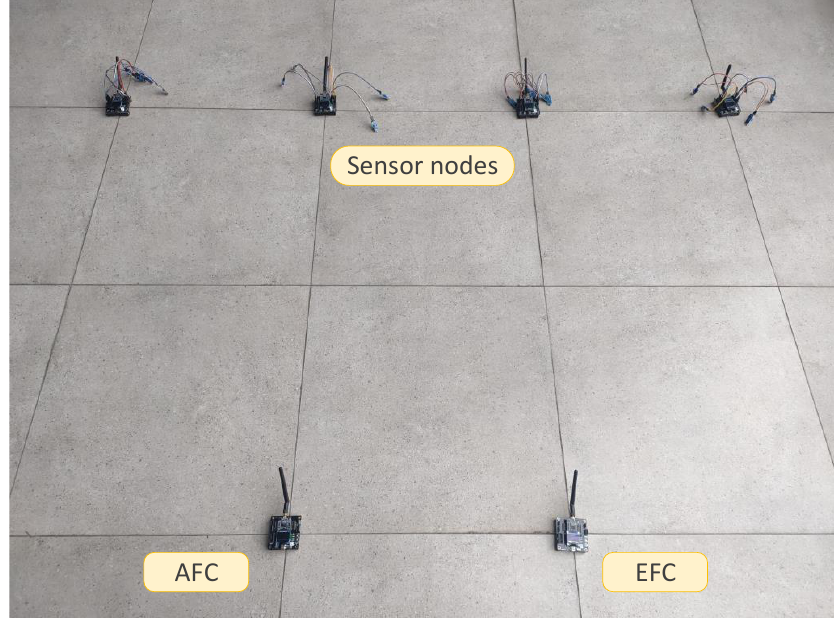
Figure 7. Sensor devices in the experiment.